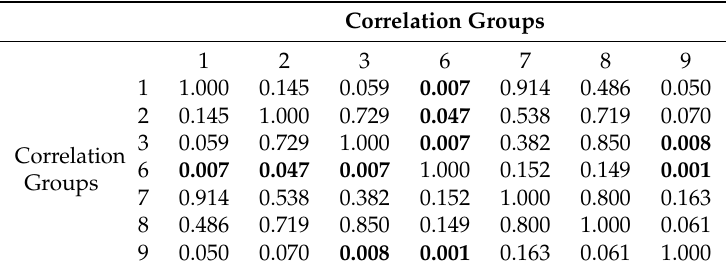
Table 7. p -values between the mean results of variable V 8 “hemoglobin” obtained from the spectra of the corresponding correlation groups.